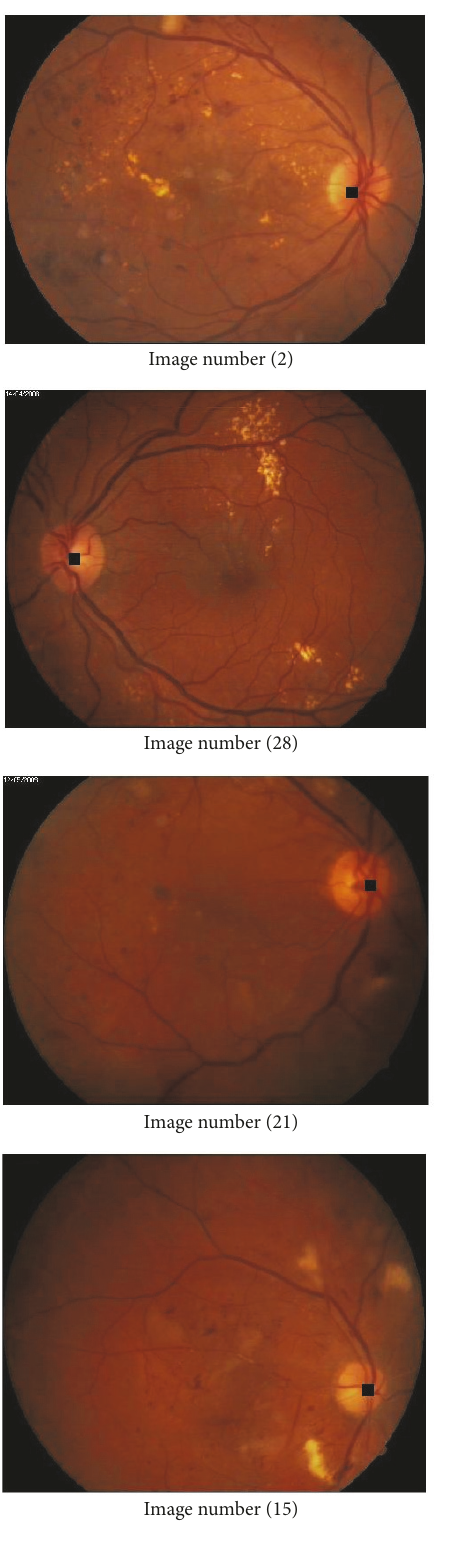
Figure 9: Sample output marked images.